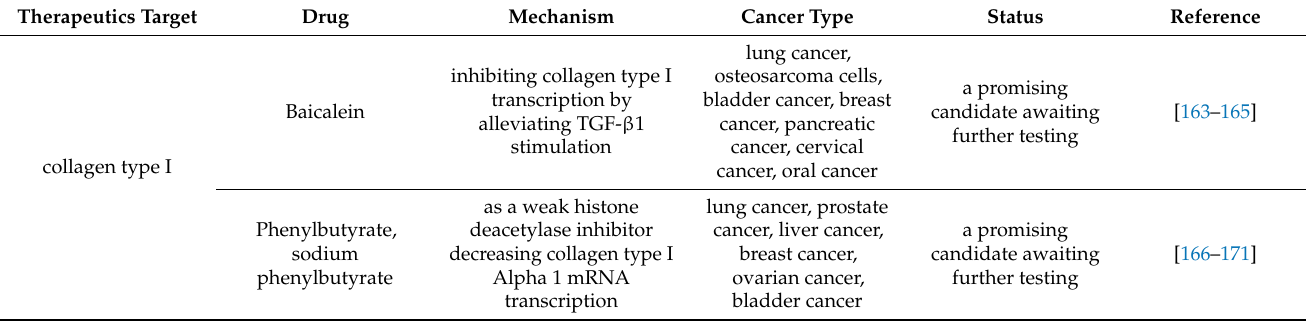
Table 2. A summary of drugs targeting the synthesis and secretion of